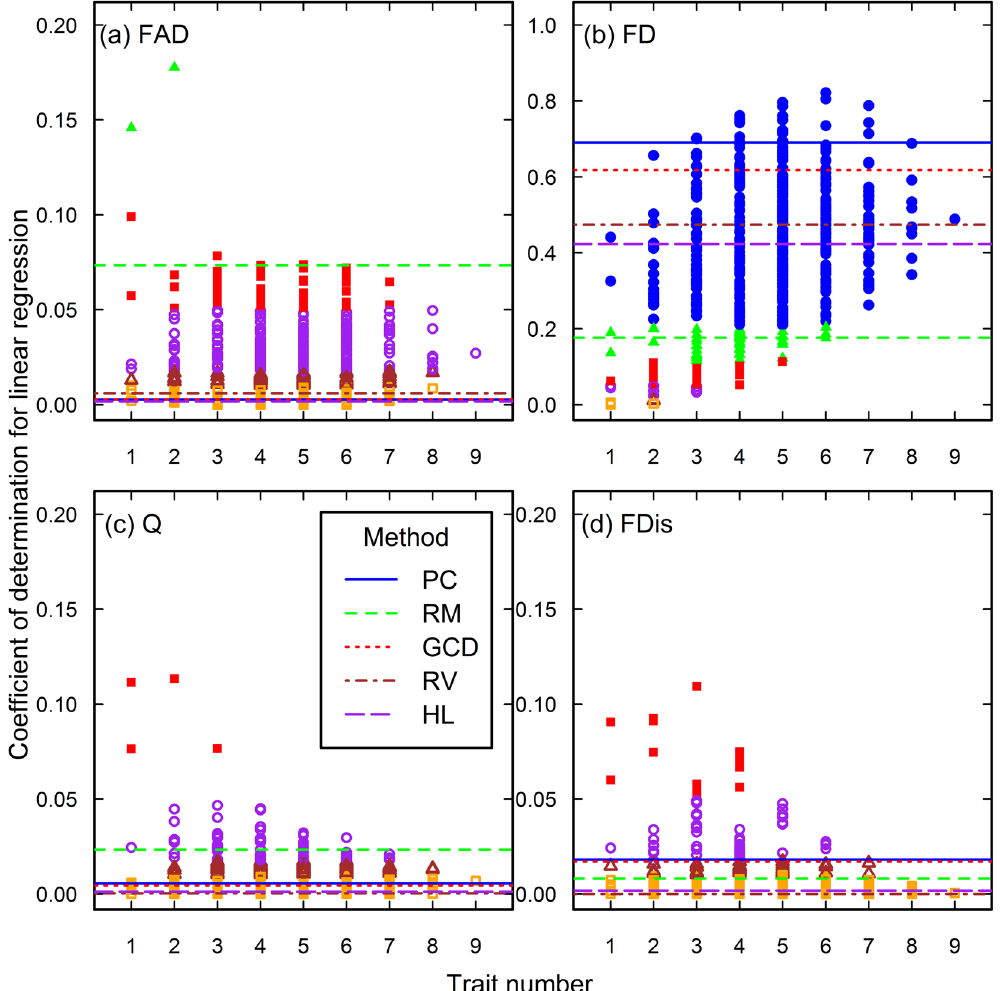
Figure 5. The closeness of associations between species richness and functional diversity in the Rehoboth data set. See the caption of Fig. 1 for the meanings of each plot, line and point. Note the ranges of coefficients of determination in the plot a, c, and d, which are different from that of the plot